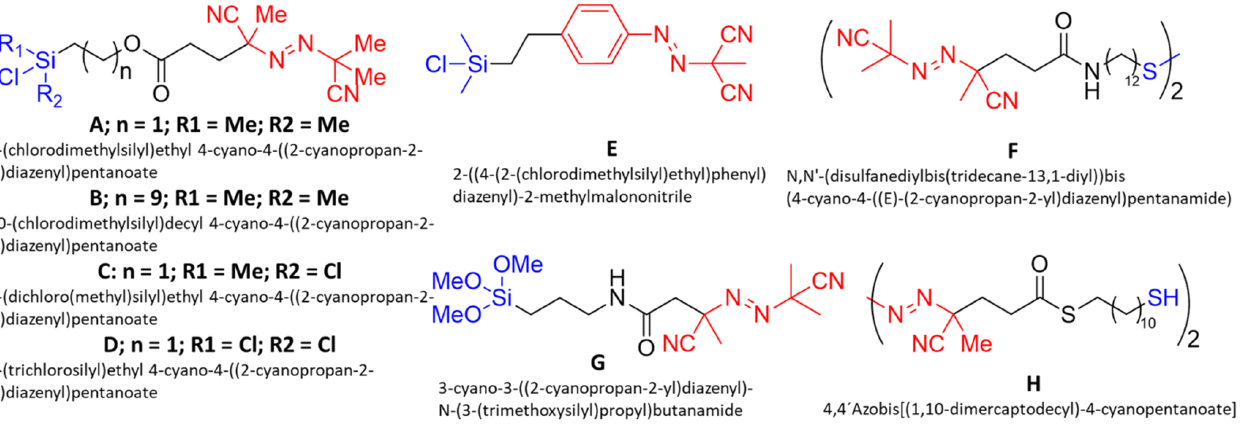
Figure 6. Photosensitive azo-compounds (red) with anchor moieties (blue).